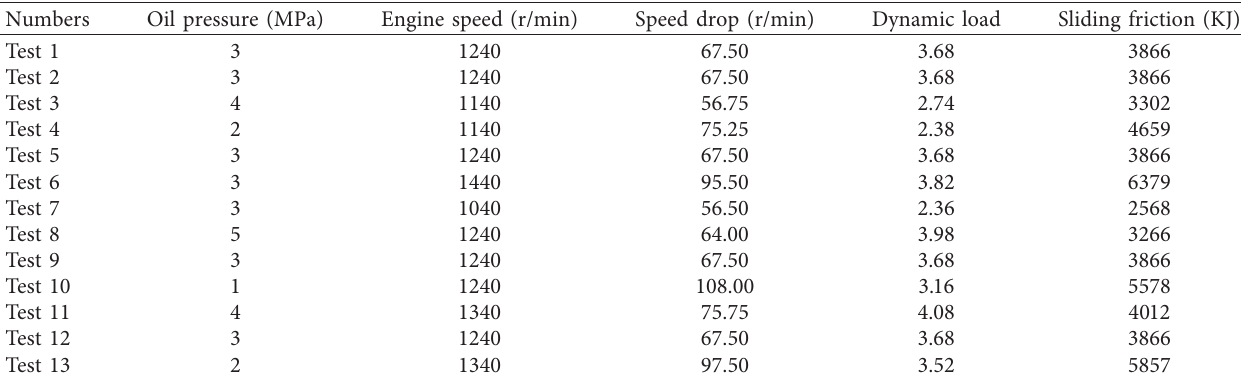
Table 2: Table of switching quality test based on RSM.